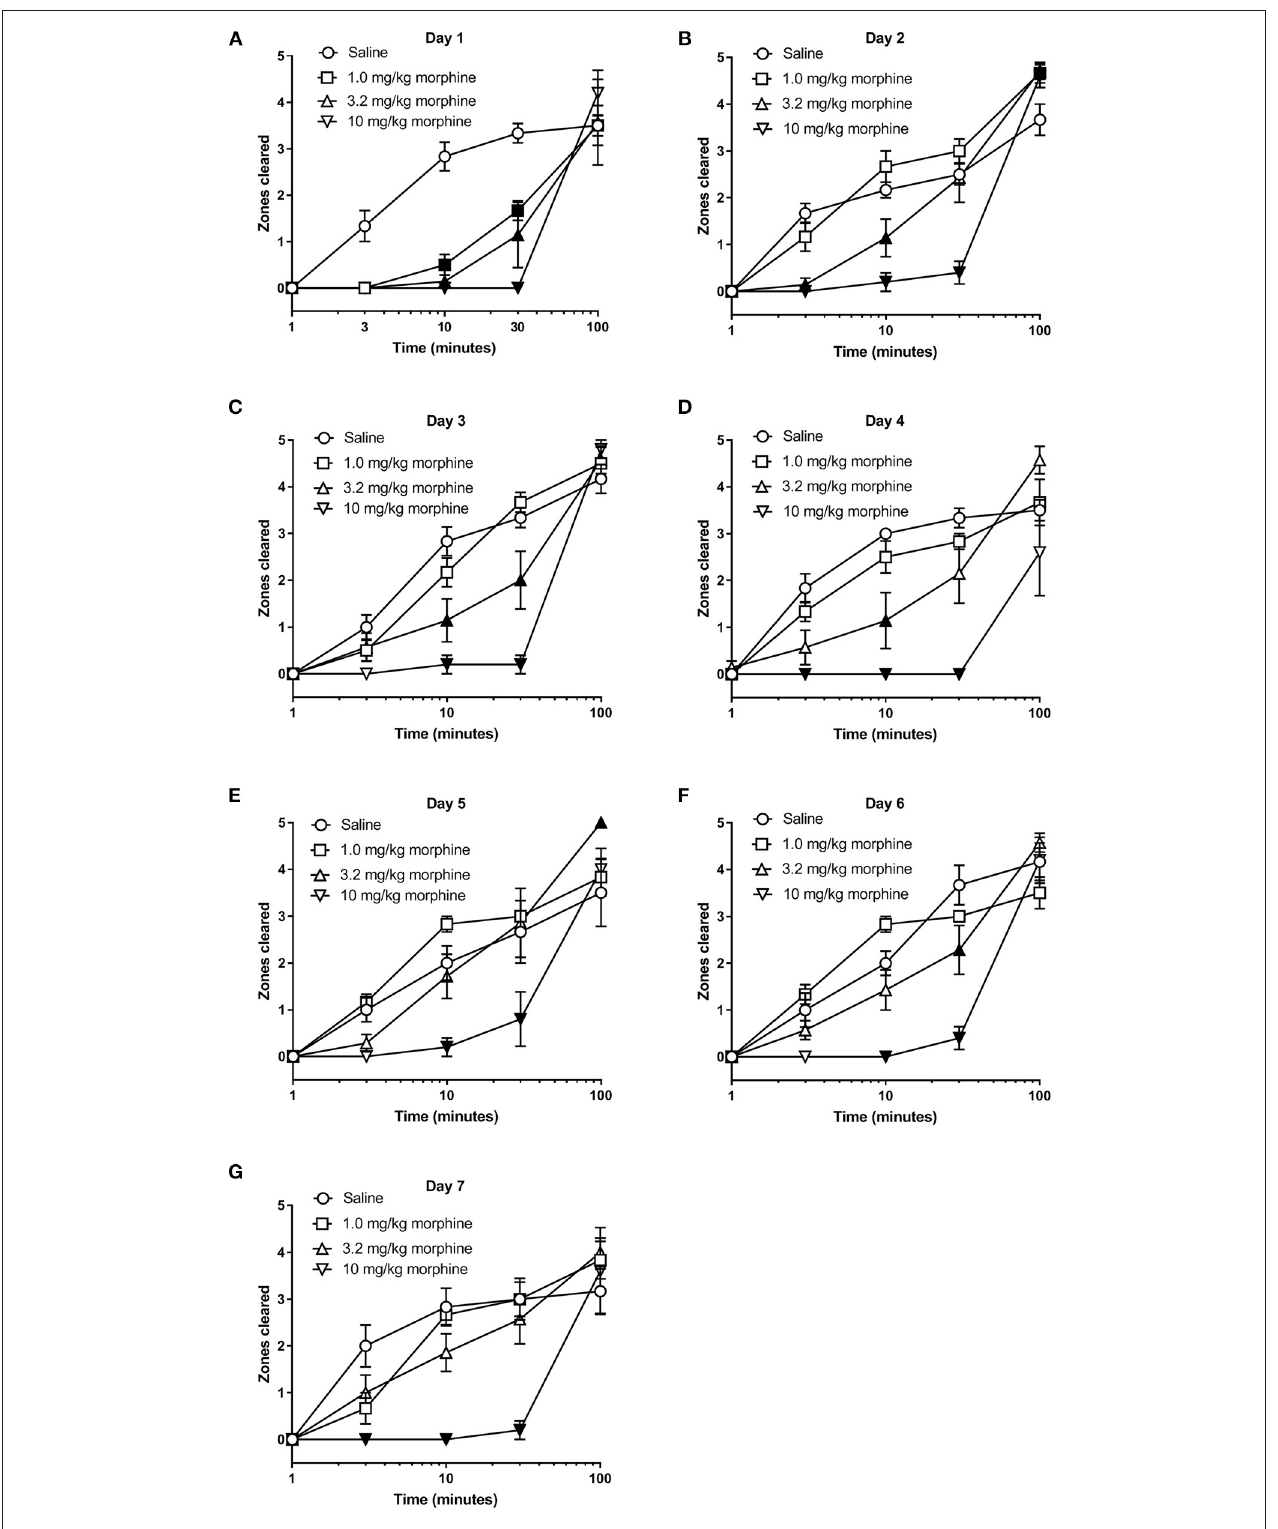
FIGURE 4 | Effect of repeated morphine treatment on nesting behavior. (A–G) show zones cleared at 1, 3, 10, 30, and 100min in mice treated daily with saline or morphine (1.0, 3.2 or 10 mg/kg/day) on Days 1–7, respectively. Nesting scores were recorded 30min after saline or morphine treatment. 1.0 or 3.2 mg//kg morphine-induced depression of nesting peaked on Day 1 and was not apparent on Day 5. Alternatively, 10 mg/kg morphine significantly